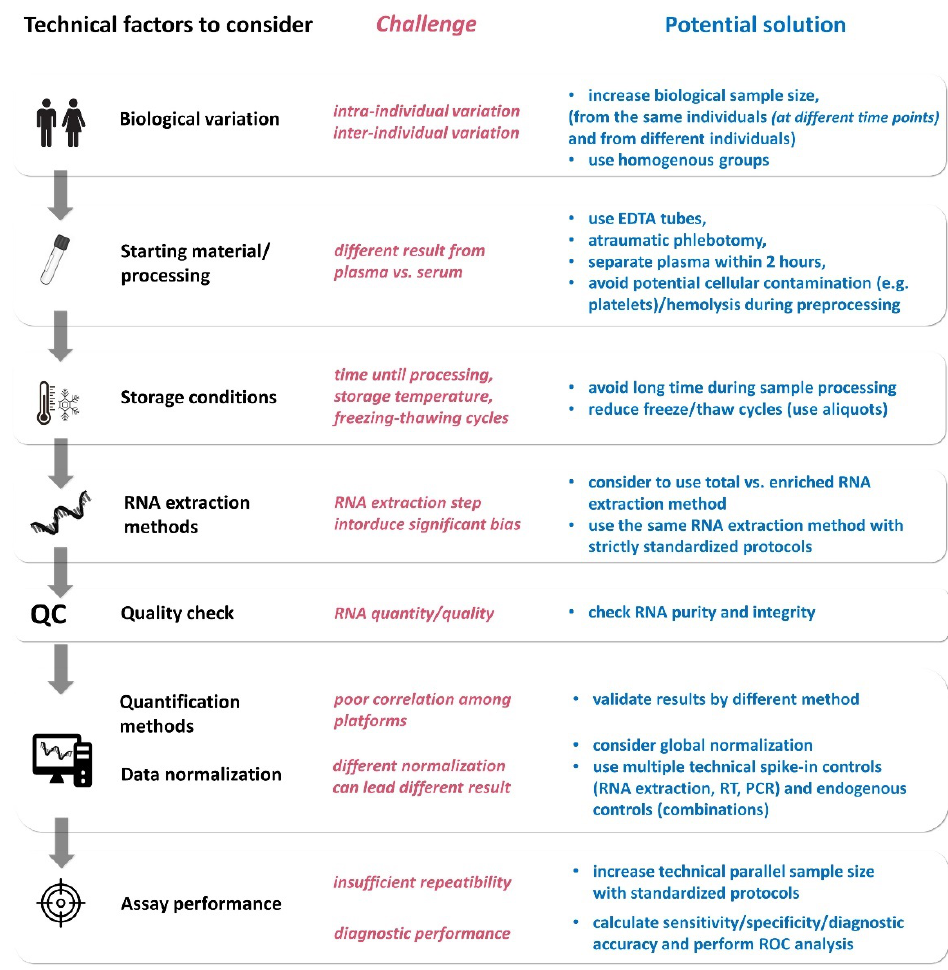
Figure 5. Technical aspects of ncRNA detection (see details in the text).